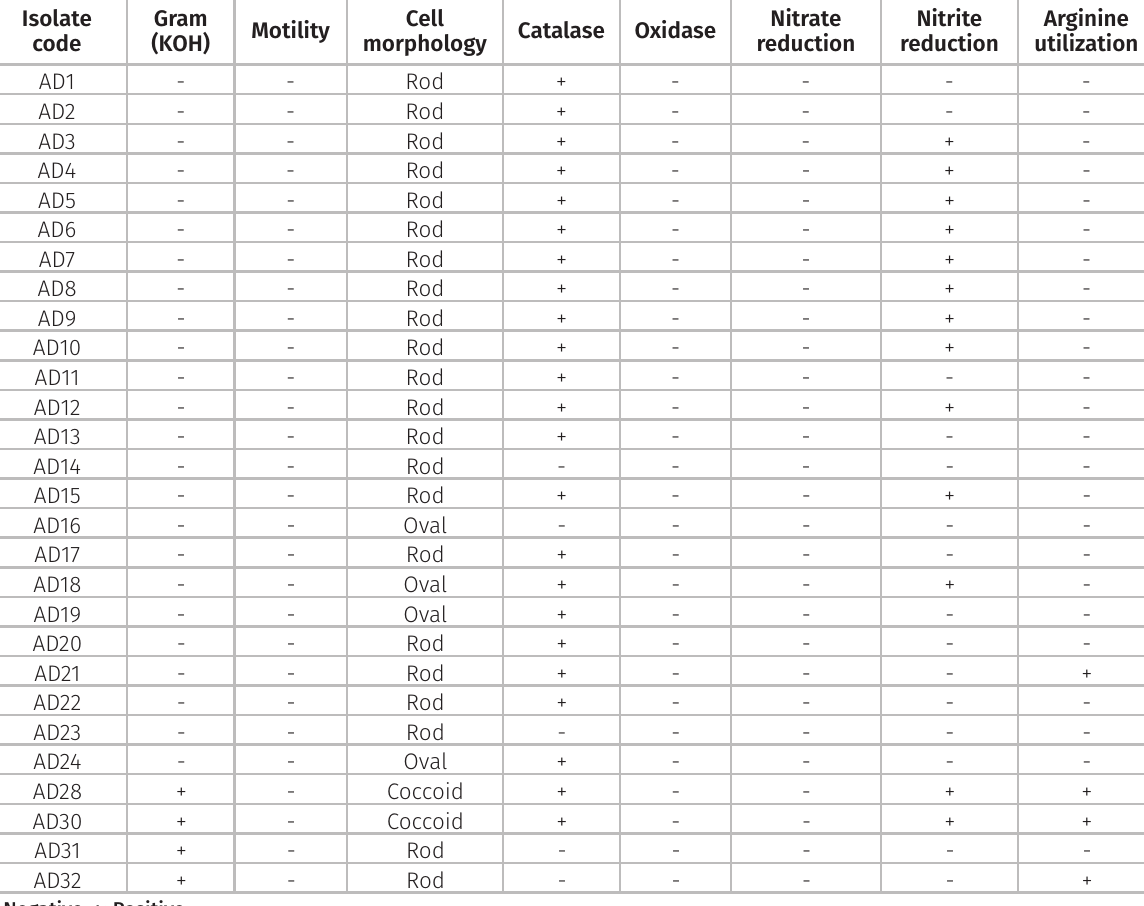
Table I. Phenotypic characteristics of the isolates. Isolate